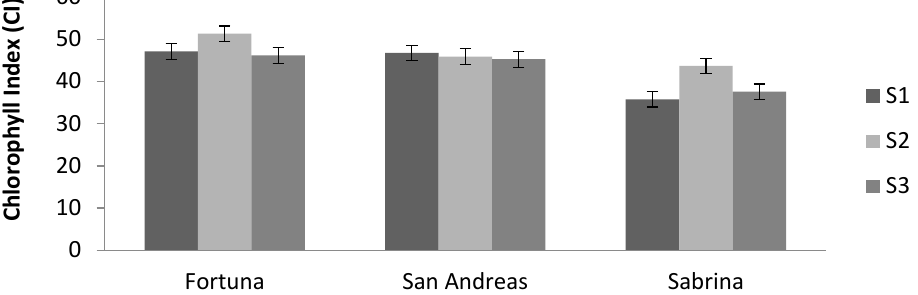
Figure 1. Mean values of chlorophyll index measured for three strawberry cultivars (Fortuna, San Andreas and Sabrina) irrigated with three nutrient solutions. K:N balance: S1 (1.3/2.0), S2 (2.6/1.0), S3 (3.0/0.6) in growth and productive period. Vertical bars indicate LSD value ( p < 0.05).